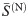
Synchronization between the breathing and the cursor’s motion was strongest during fully-developed chaos.(A) Normalized synchronization indices Sth(N) and Sab(N) as a function of the control parameter a, shown for different values of the frequency ratio n (period doubling and halving). (B) Normalized S¯(N) as a function of Δϵ for a = {0.25, 0.35}. Borderline and significant rank correlation were observed for a = {0.25, 0.35}, respectively. * represents p < 0.05, ** represents p < 0.01, and *** represents p < 0.001.